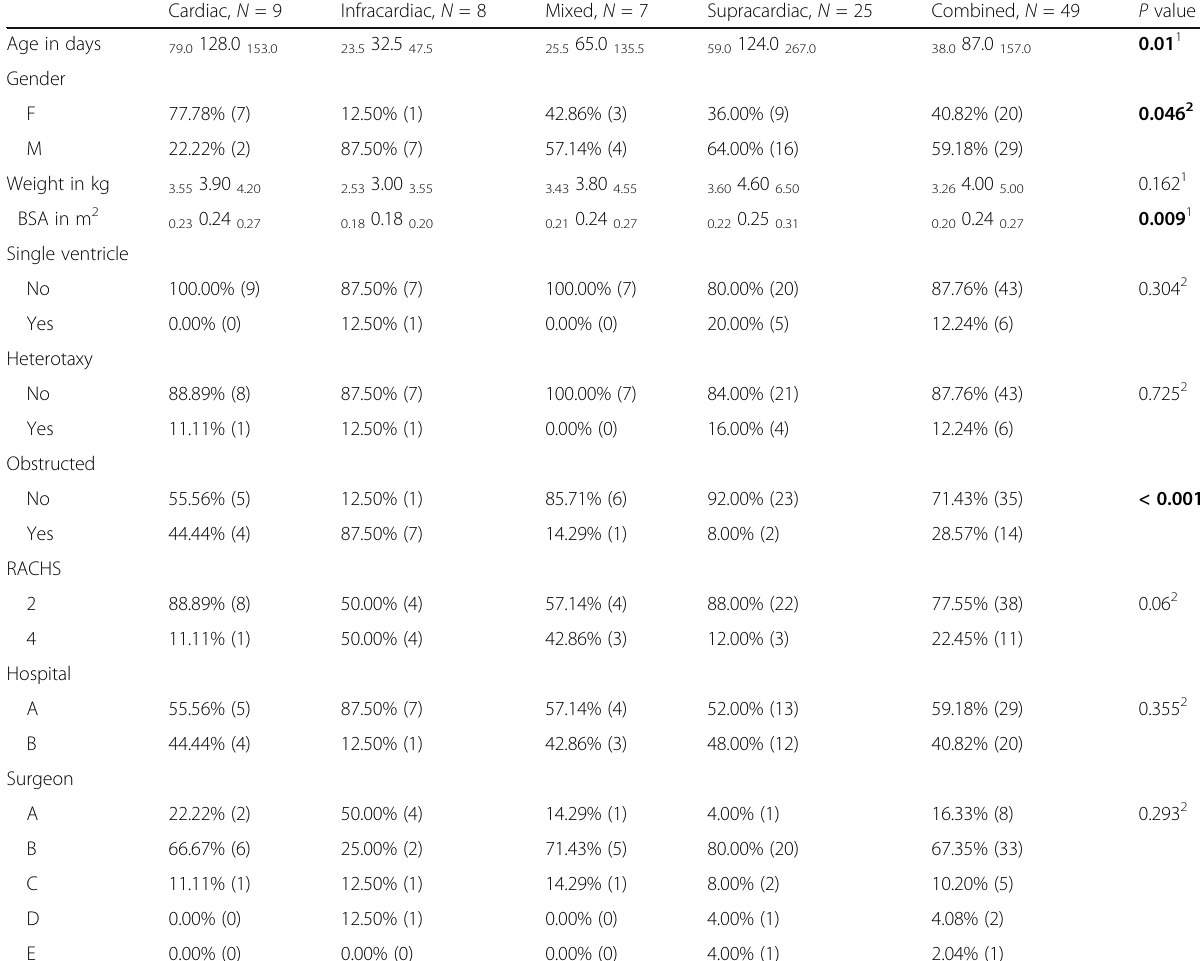
Table 1 Descriptive statistics by TAPVD type ( N = 49)